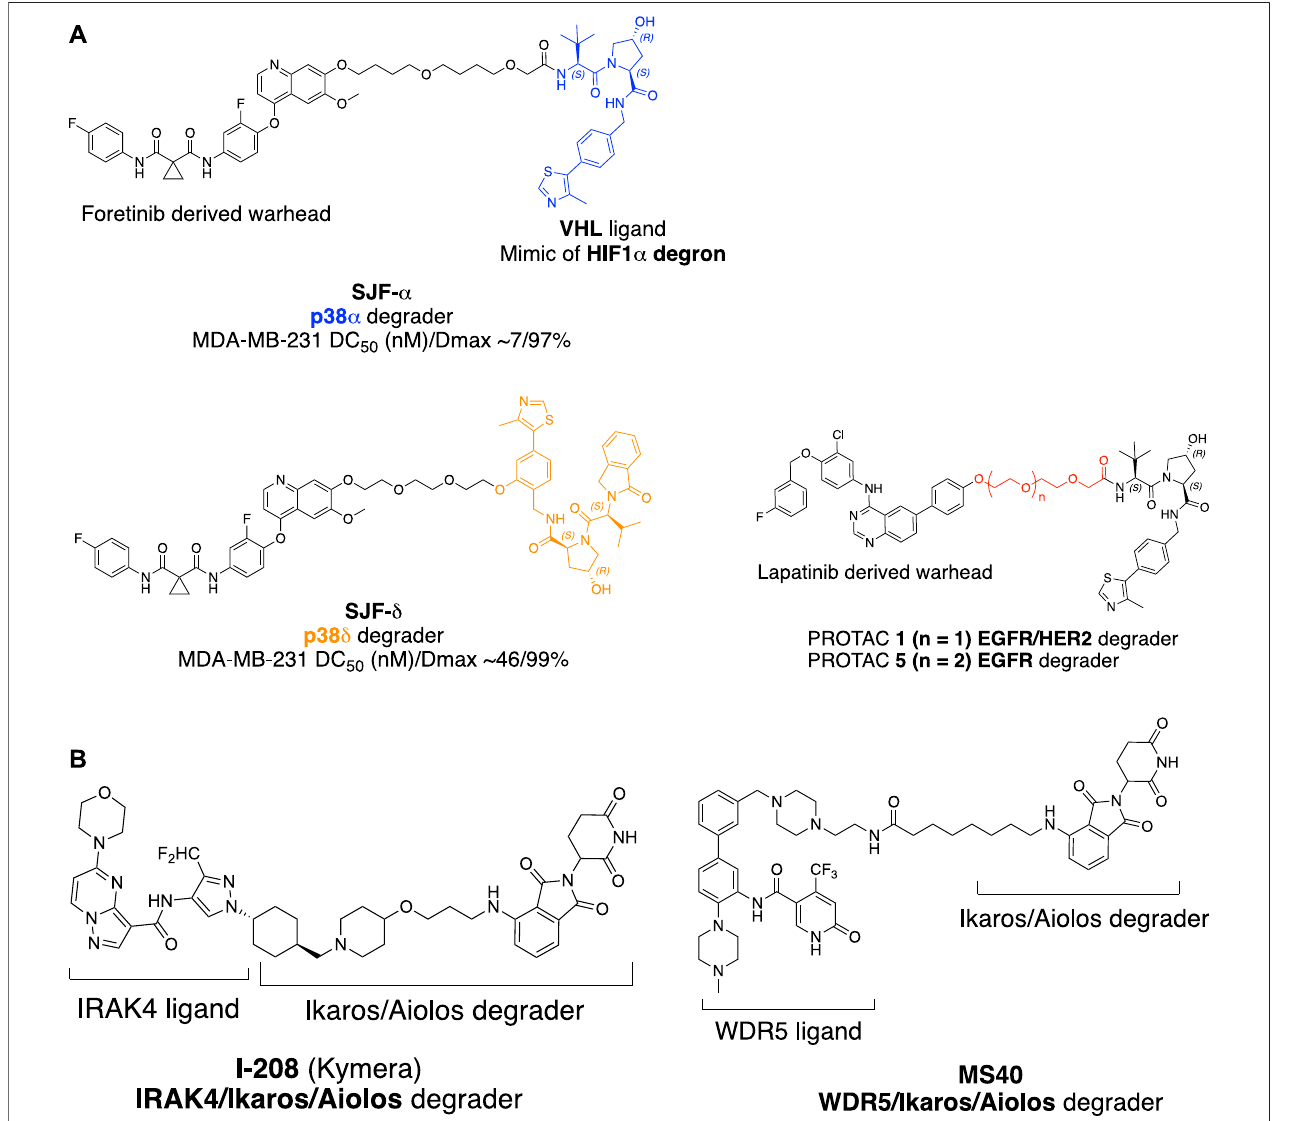
FIGURE1 | Factors in fl uence the selectivity ofdegraders. (A) PROTAC withdifferentlinkerattachmentpoint to the VHLligand selectively degrade p38 α and p38 β . (B) Structure of IRAK/Ikaros/Aiolos multi-targets degrader I-208 and WDR5/Ikaros/Aiolos multi-targets degrader MS40 . (C) Bcl-2/Bcl-xL dual degradation by 753bR achievedwithdifferentlinkerattachmentpointstowarhead;andcrystalstructureofNavitoclaxwithBCL-2(Souersetal.,2013)withfourpocketsindicatedwithanarrow. The crystal structure was processed with PyMOL. (D) Trivalent PROTAC with multi-protein or multi-domain binding warheads. MZ1 with a preference for BRD4 degradation, SIM1 with a preference for BRD2 degradation.